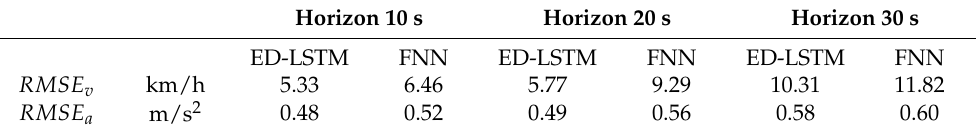
Table 3. RMSE with map data for different prediction